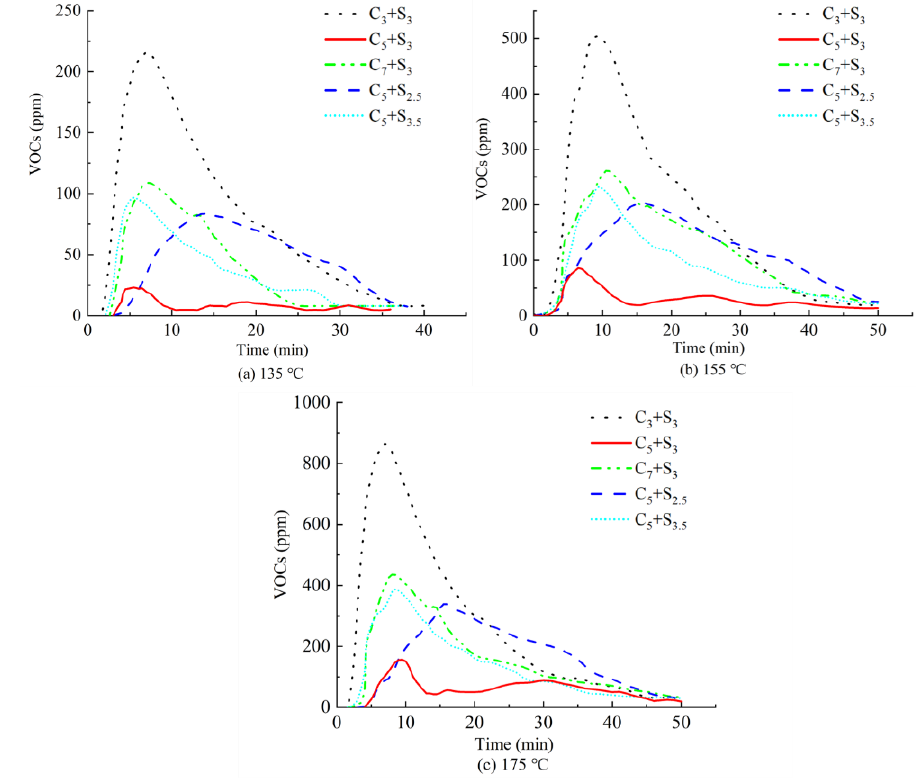
Figure 10. VOCs emission curve of environmentally friendly modified asphalt at different temperatures.